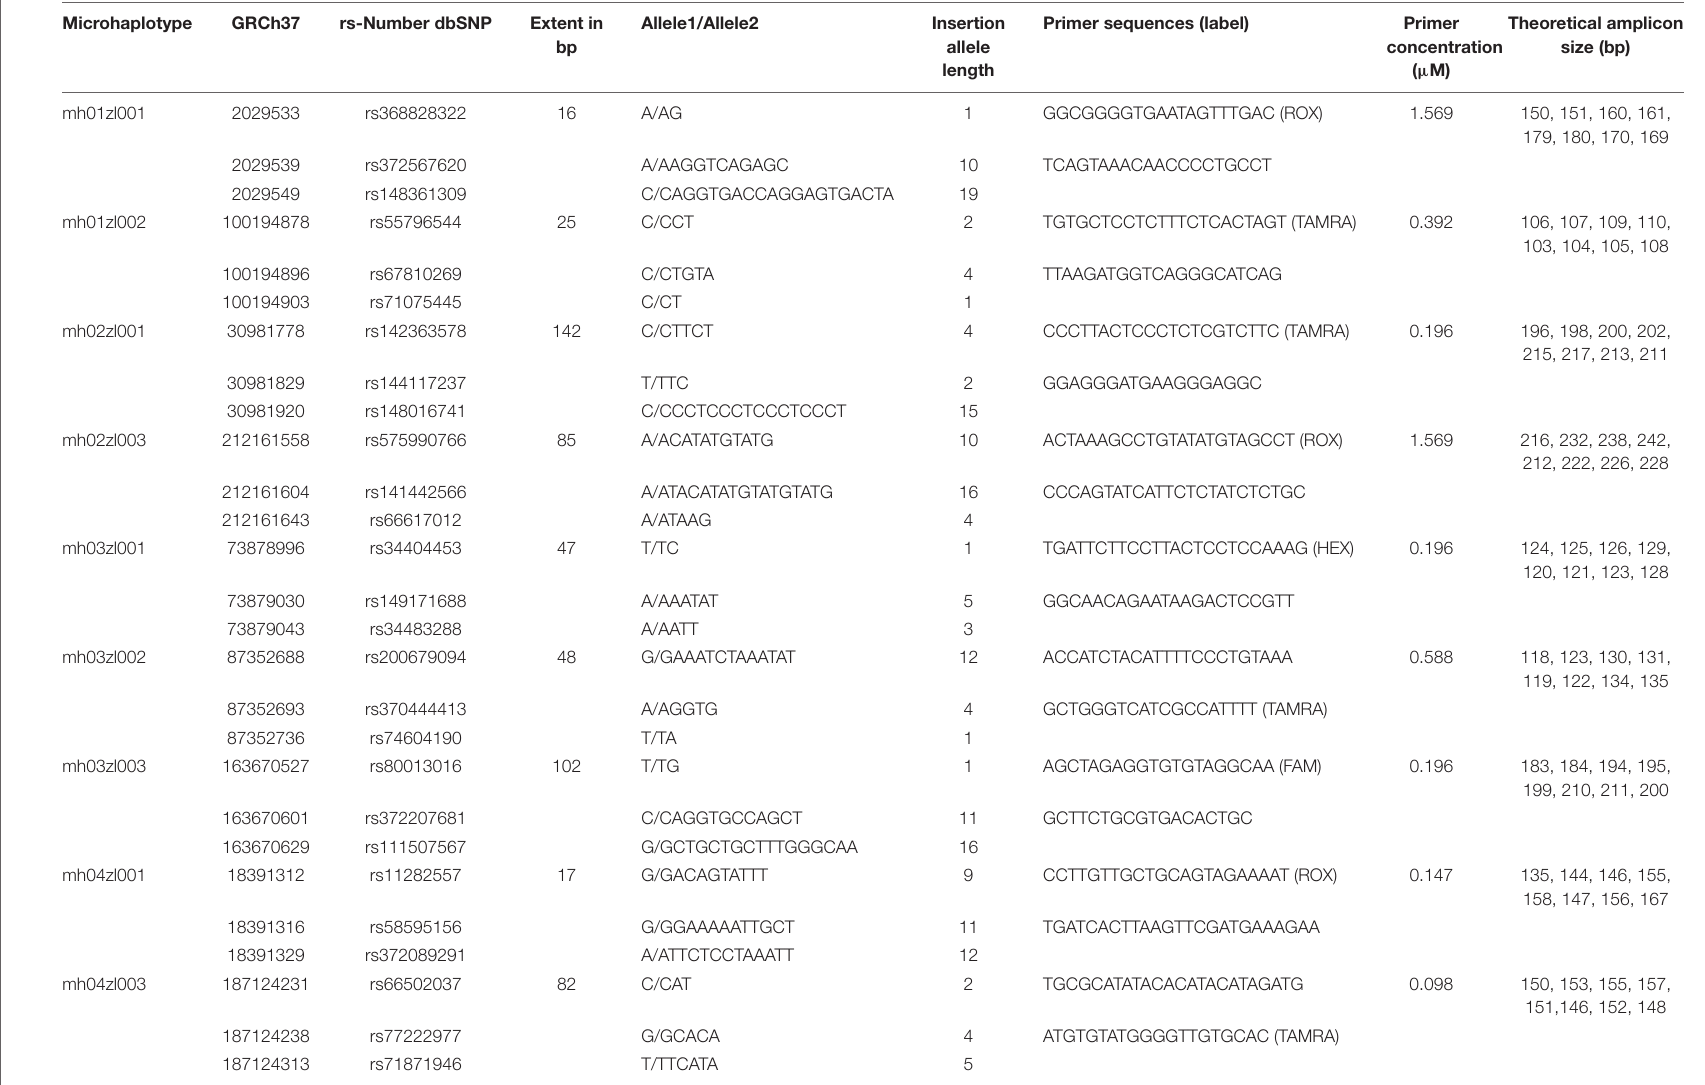
TABLE 1 | The general information of 18 multi-Indel